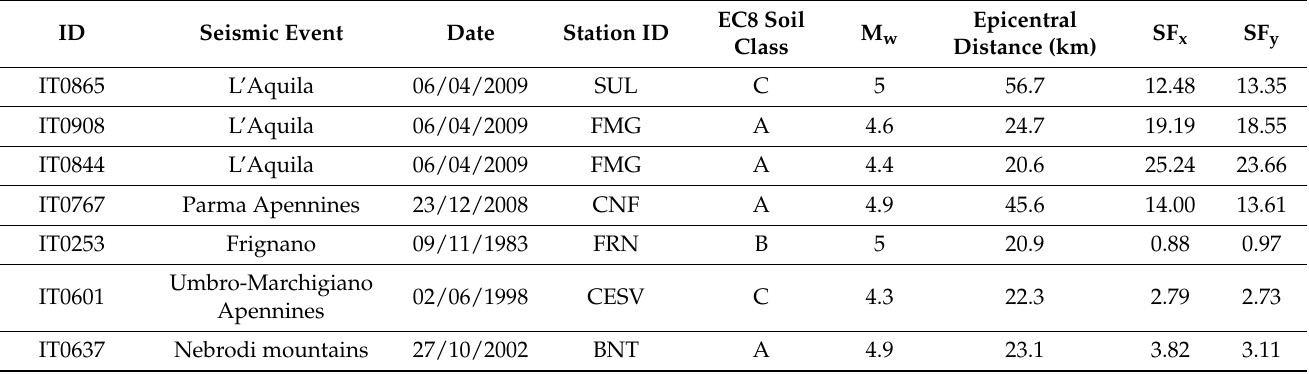
Table 6. Characteristics of the real accelerograms selected for a 50-year return period of the seis- mic action. M w is the moment magnitude and SF is the scale factor applied to obtain spectrum compatibility.